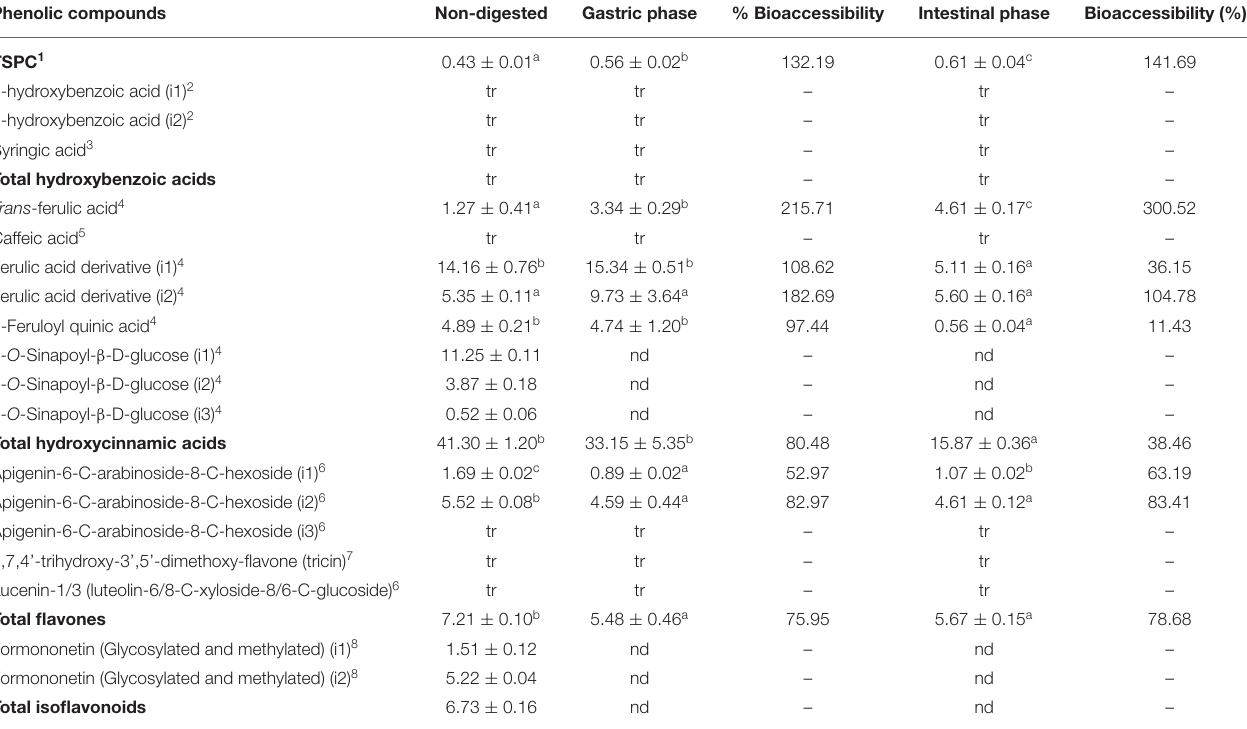
Data are mean values ± standard deviation of three replicates. Different lowercase letters in the same row indicate significant differences of means in different digestion phases (one-way ANOVA, post-hoc Duncan’s test, p ≤ 0.05). i, isomer; nd, non-detected; tr, traces; TSPC, total soluble phenolic compounds. 1 g gallic acid equivalents/100g. 2 mg